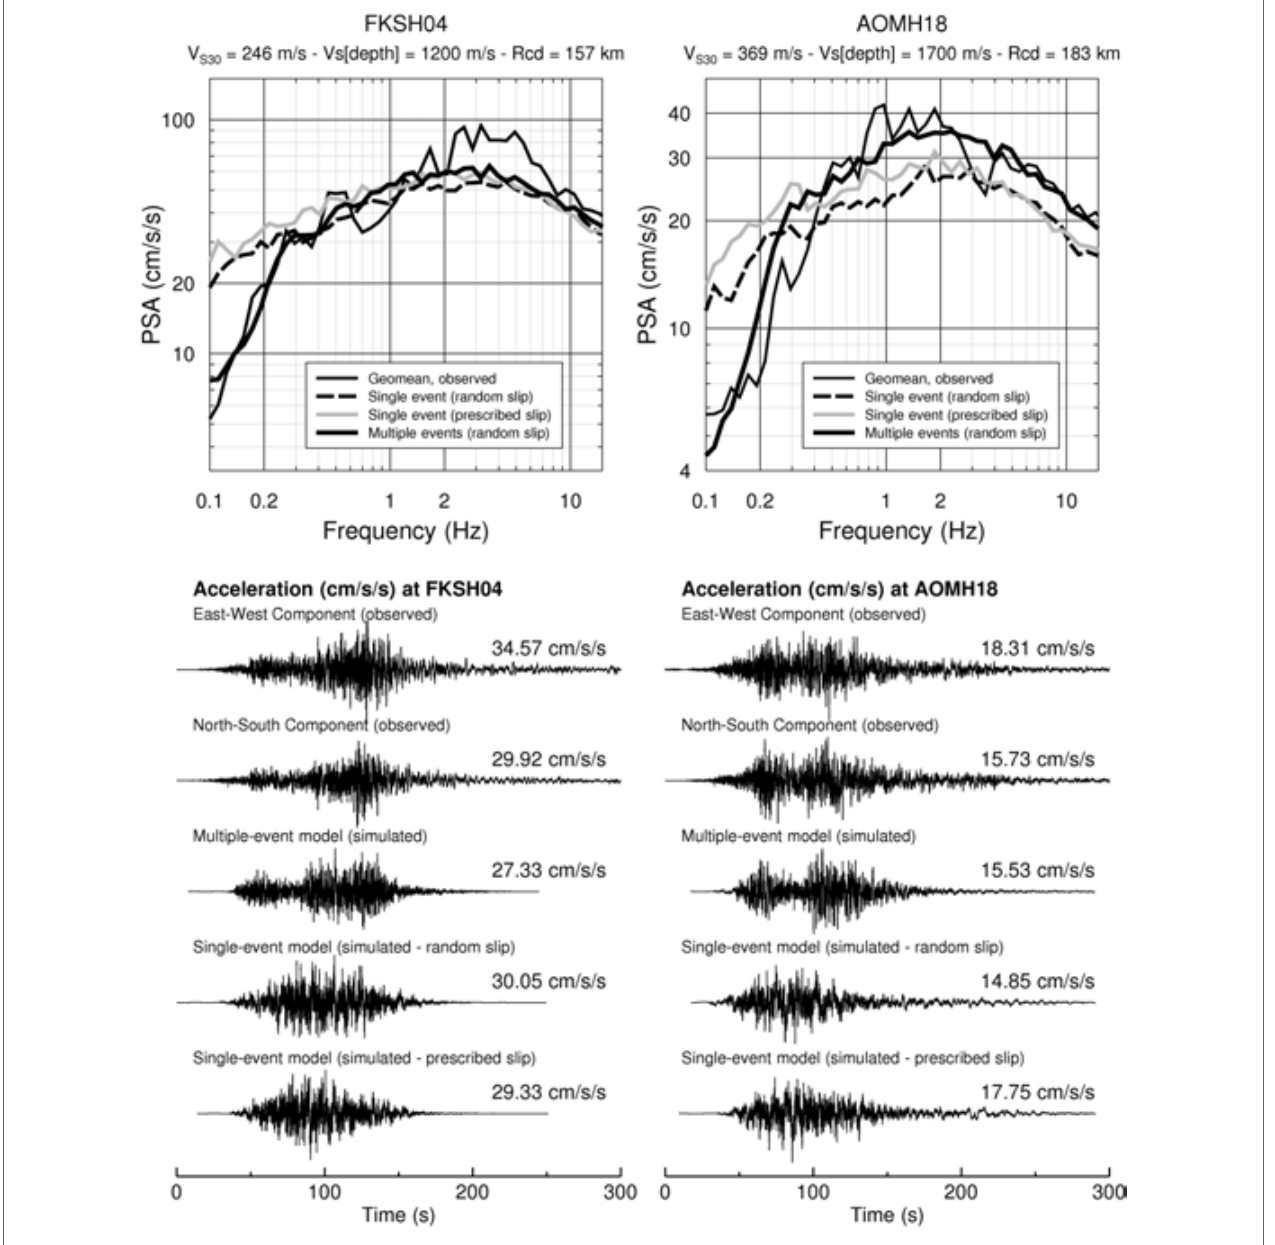
FIGURE 2 | Comparison of observed (borehole) and simulated pseudospectral acceleration (PSA) for two selected stations. Simulated PSAs are the average of 30 trials for each case (single-rupture models with random and prescribed slip, and multiple-rupture model). Depths of borehole installation for FKSH04 and AOMH18 are 268 and 100m,